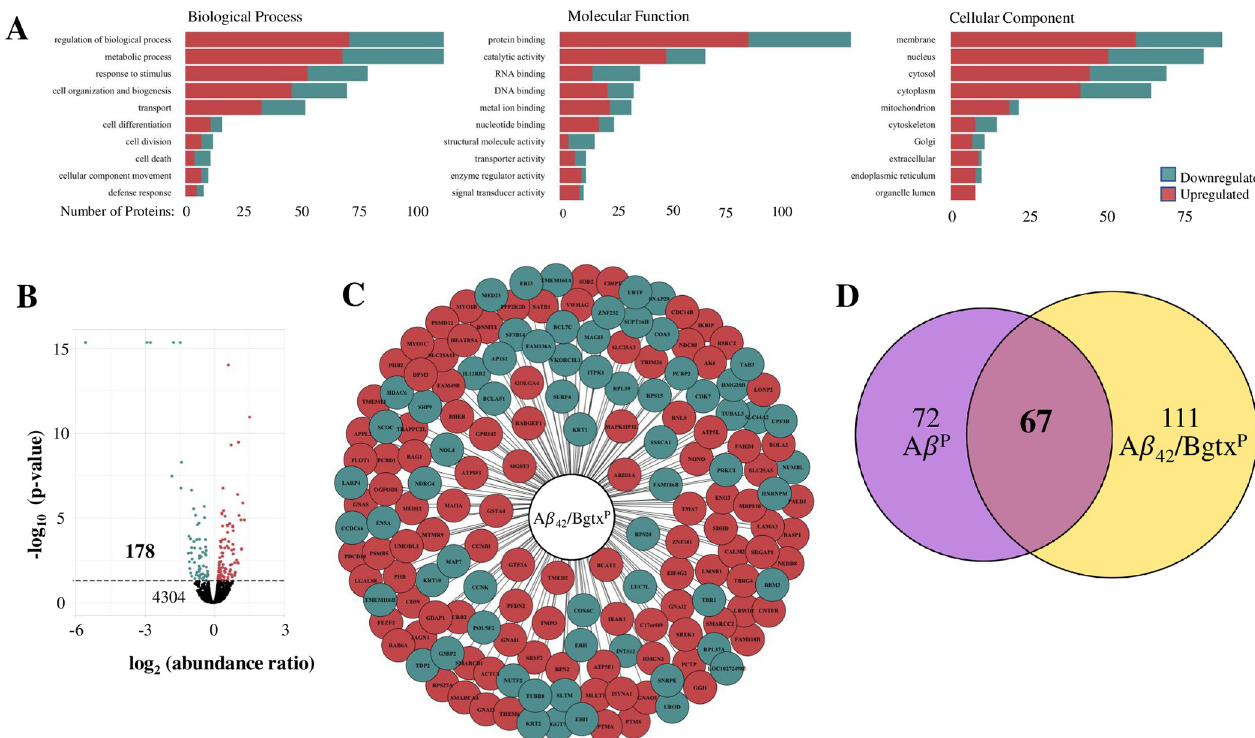
Fig 3. Proteome response to A β 42 + Bgtx co-treatment. A) The number of proteins within the A β 42 /Bgtx P associated with GO terms. B) The distribution and number of detected proteins within A β 42 + Bgtx treated cells. The horizontal line indicates the threshold for statistical significance (p < 0.05). C) Components of the A β 42 /Bgtx P identified by gene symbols. D) The number of proteins within the A β 42P and A β 42 /Bgtx P datasets. 67 proteins are found in both.